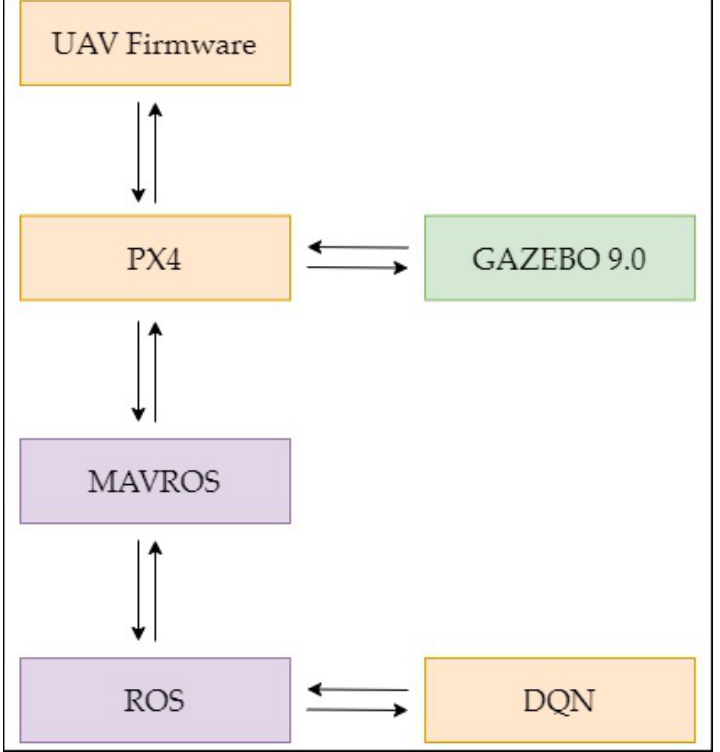
Figure 8. Framework overview. Gazebo simulates all the environments which interact with the UAV FCU PX4. DQN algorithm controls the agent via